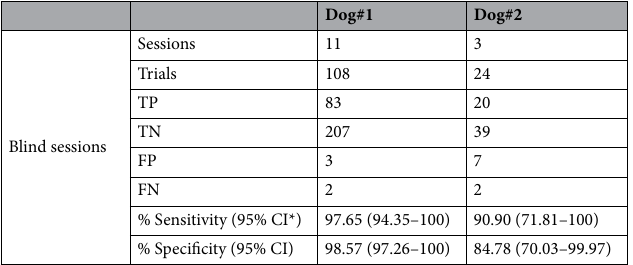
Table 2. Scent detection of OST3 cells. *Confidence interval calculated with the values obtained in the different